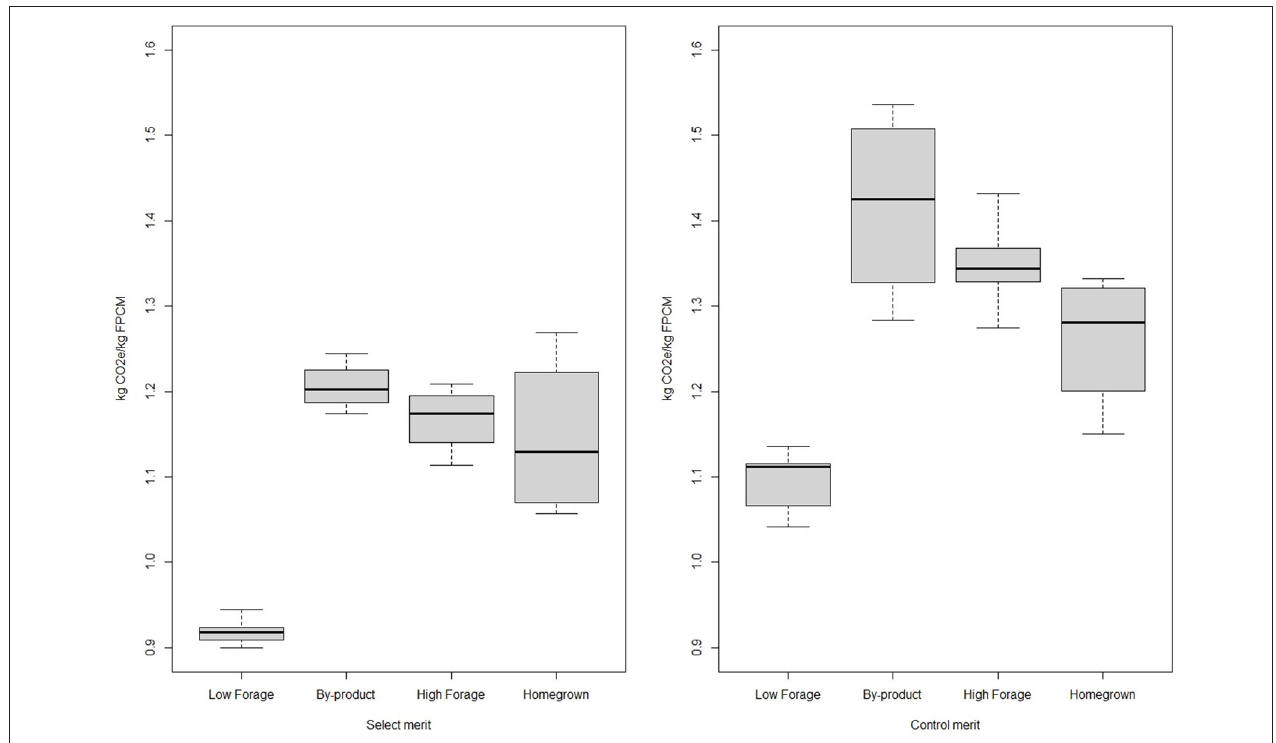
TABLE 8 | Dairy system GHG emissions (kg CO 2 e/kg FPCM) by category using economic allocation of feeds and considering nutritional variation of both CP and NCGD. Land Livestock Embedded Energy Sequestration Total Mean sd Mean Mean